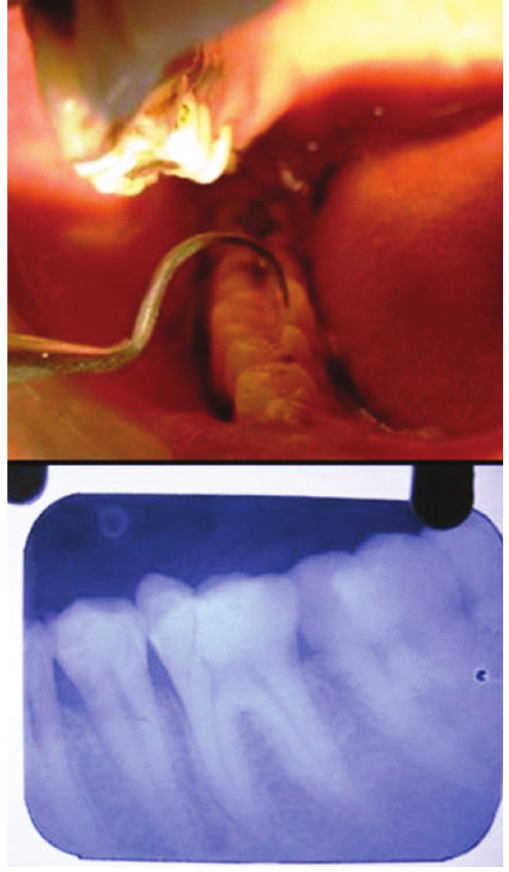
Figure 1: Vertical coronal fracture in mandibular molar, pre-oper- ative radiograph.